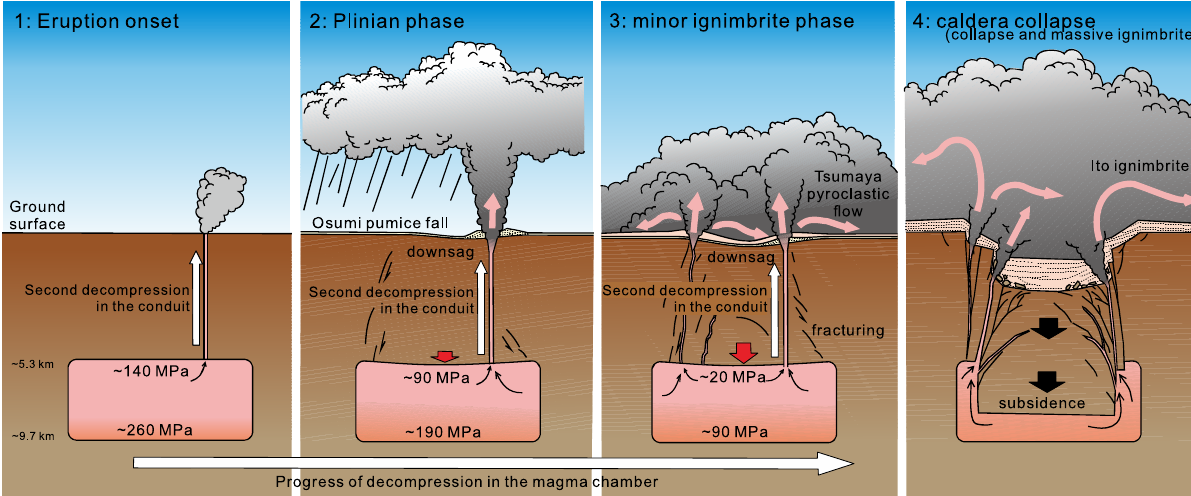
Fig. 4 Evolution of magma decompression during the AT eruption. Decompression of magma chamber and deformation of the host rock toward the caldera collapse and eruption of massive ignimbrite. A rhyolite magma chamber was subjected to lithostatic pressures of 140 – 260MPa, corresponding to depths of 5.3 – 9.4km below the surface of the Aira volcano before the eruption. Extraction of magmas from the magma chamber caused decompression in the magma chamber. Pressure in the magma chamber decreased to ~90 – 190 MPa due to the extraction of the magma by the eruption of the Osumi pumice fall during the Plinian phase. Down-sag deformation of the roof rock was initiated by the pressure difference between the lithostatic pressure acting on the host rock of the magma chamber and the decreasing magmatic pressure in the chamber during the Plinian phase. The extracted magmas were decompressed rapidly during their ascent through the conduit to the ground surface. Caldera collapse started when blocks of roof rock detached by the ring fracture subsided into the magma chamber. The subsidence of the blocks into the magma chamber accelerated further magma output, to form a massive